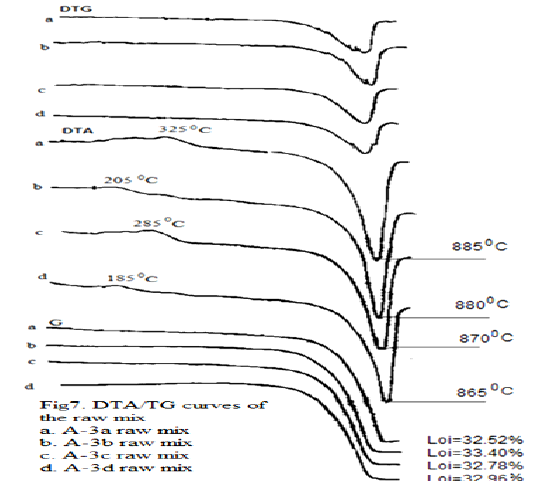
Fig. 7. DTA/TG traces of mixtures with CaF 2